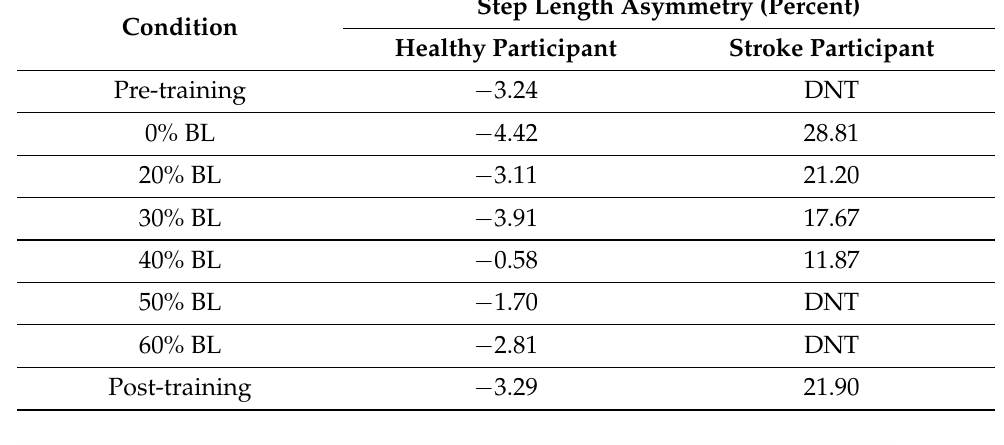
Table 6. Step length asymmetry. A positive asymmetry means step length of the resisted or paretic leg is longer.